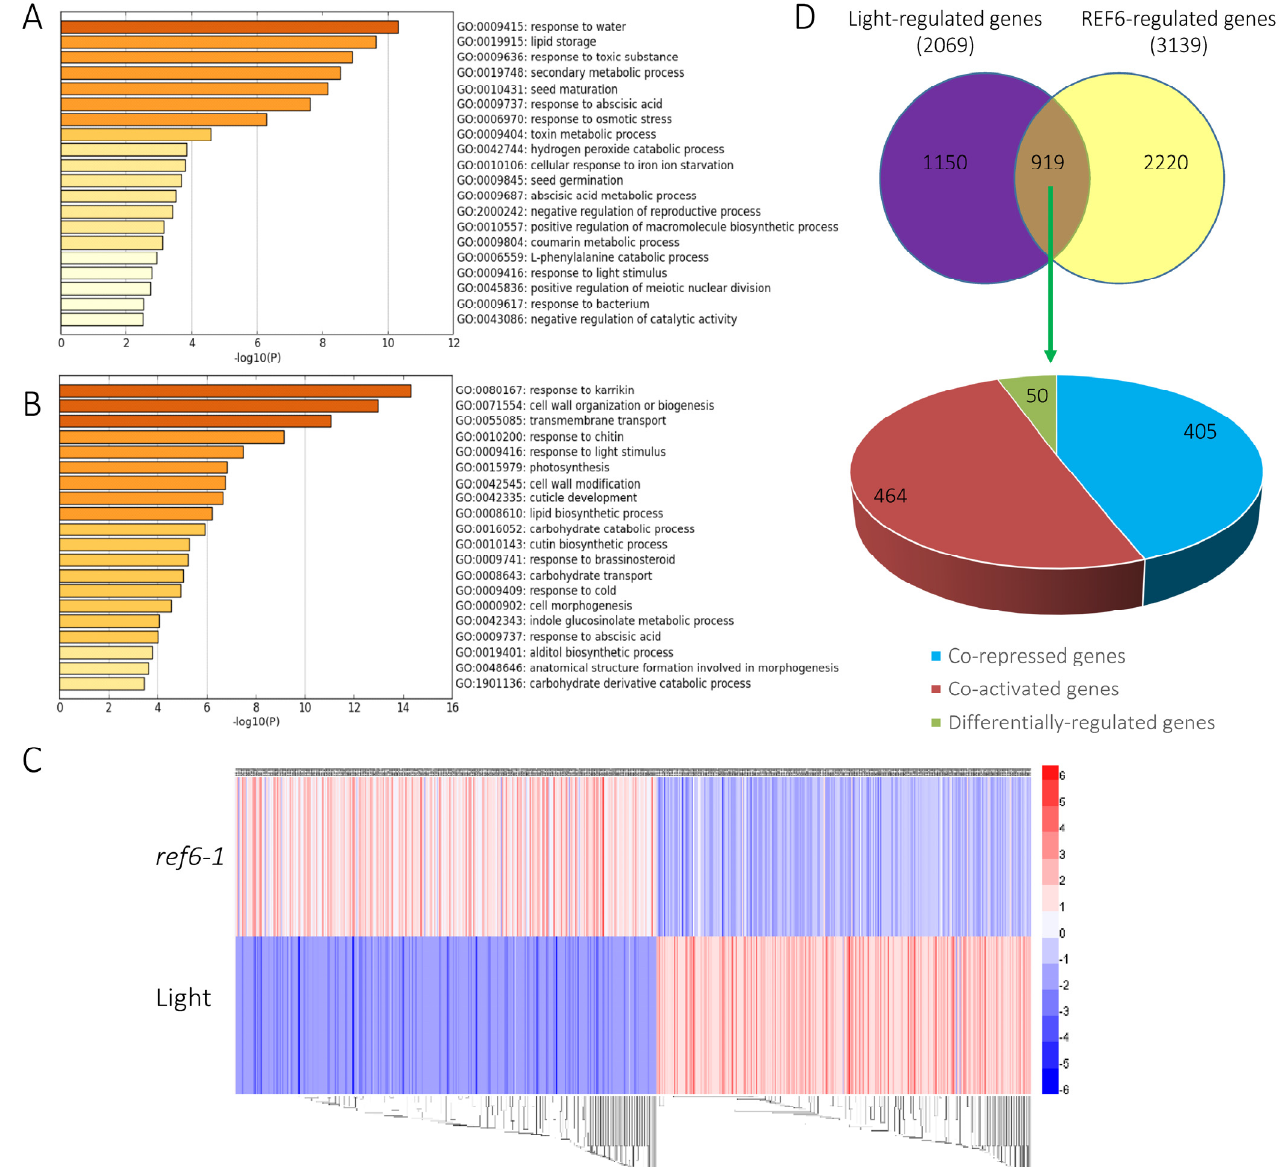
Figure 3. Genome-wide identification of REF6-regulated genes in imbibed seeds under FR/R conditions. ( A ) Chart of enriched ontology gene clusters repressed by REF6 ( p < 0.05). ( B ) Chart of enriched ontology gene clusters activated by REF6 ( p < 0.05). ( C ) Heatmap displaying the up- and down-regulated genes in ref6-1 in comparison with the light-regulated genes as reported. ( D ) Venn diagram analysis of overlapping genes co-regulated by REF6 and light.